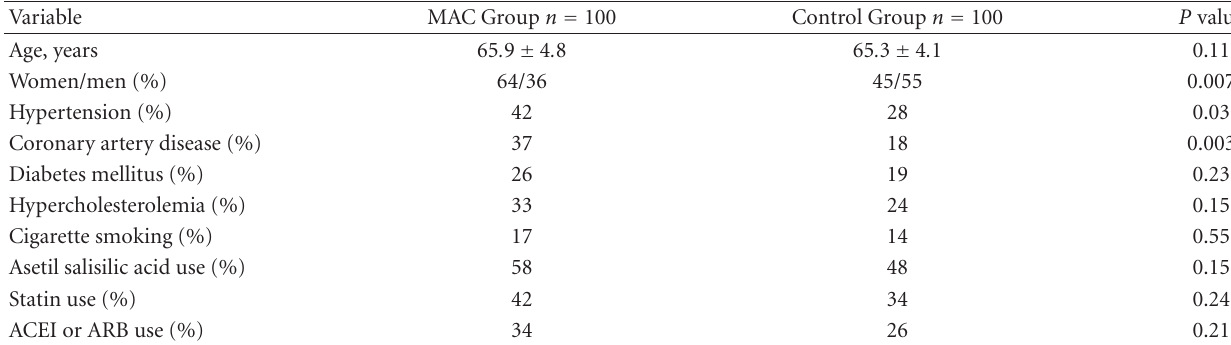
Table 1: Baseline characteristics of the study population.